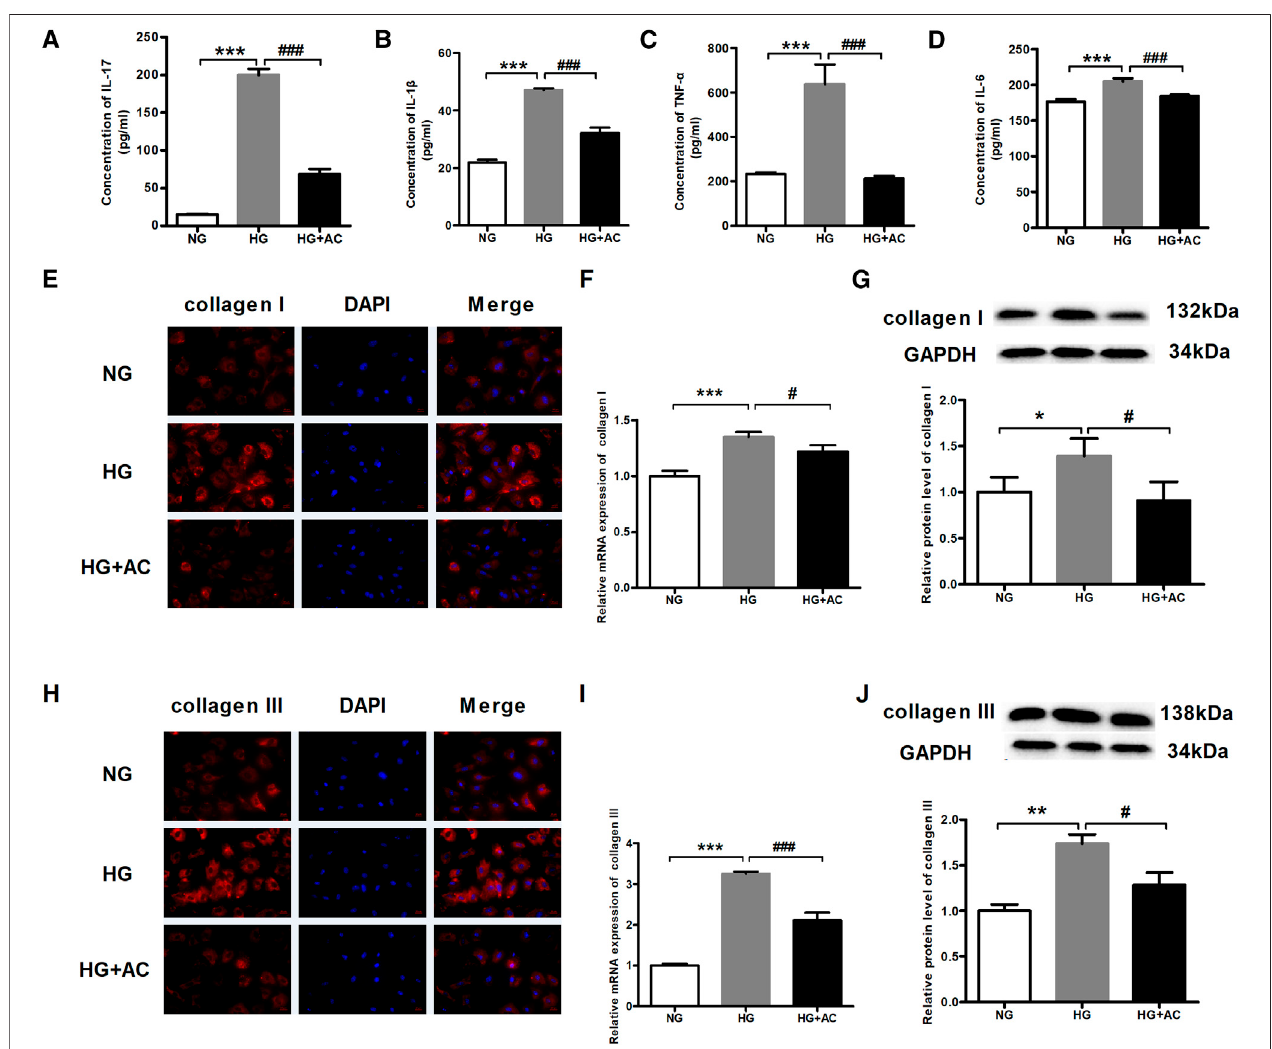
FIGURE4| Anthocyaninreducesmyocardial fi brosisandthelevelsofin fl ammatorycytokinesincardiac fi broblastsfromneonatalmiceinducedbyhighglucose. (A) Concentrationofinterleukin(IL)-17detectedbyenzyme-linkedimmunosorbentassay(ELISA). (B) ConcentrationofIL-1 β detectedbyELISA. (C) ConcentrationofTNF- α detectedbyELISA. (D) ConcentrationofIL-6detectedbyELISA. (E) Theimmuno fl uorescencestainingofcollagenI.Scalebar:20 μ m. (F) Relativeexpressionofcollagen I mRNA detected using quantitative reverse transcription PCR (qRT-PCR). (G) Relative protein level of collagen I. (H) The immuno fl uorescence staining of collagen III.Scalebar:20 μ m. (I) RelativeexpressionofcollagenIIImRNA. (J) RelativeproteinlevelofcollagenIII.GAPDHservedasaninternalcontrol.* p < 0.05vs.NG,** p < 0.01 vs. NG, *** p < 0.001 vs. NG, # p < 0.05 vs. HG, ### p < 0.001 vs. HG. NG, normal glucose (5.5 mM); HG, high glucose (25 mM); HG + AC, high glucose (25 mM) + anthocyanin (250 μ g/ml); n (cid:1)